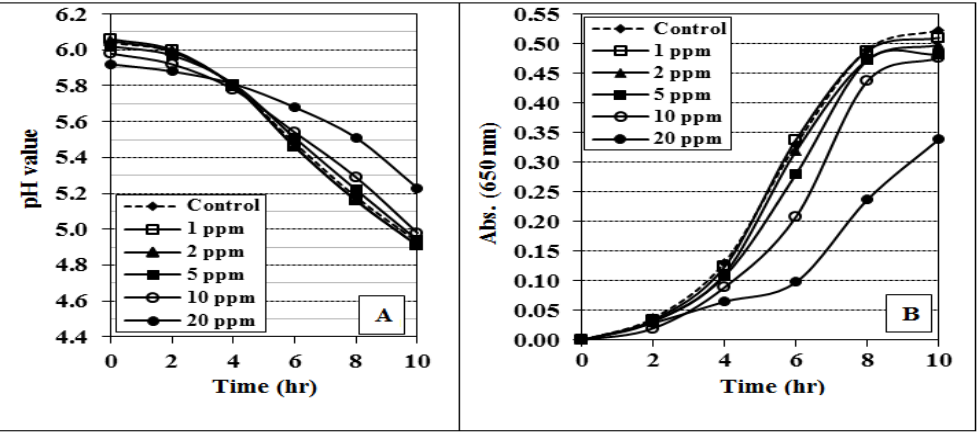
Figure 3. Effect of chromium picolenate (CrPic) on the pH ( A ) and absorbance ( B ) progress of MRS broth media inoculated with yoghurt culture and incubated at 40 °C for 10 h. The data are shown as mean ± SE for three replicates.